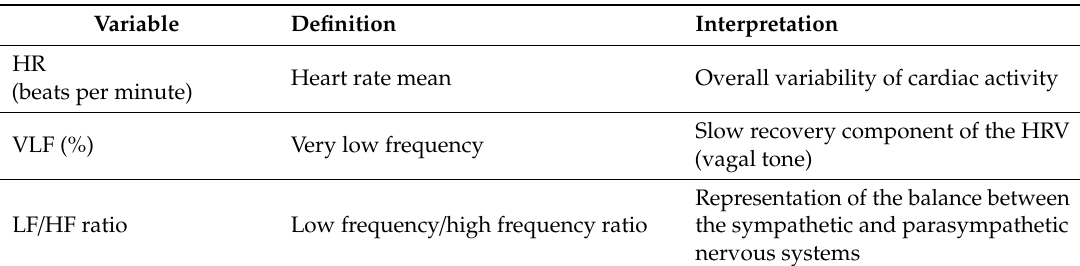
Table 3. Adapted description of heart rate variability (HRV) variables from Stucke et al., 2015 and Usui and Nishida, 2017